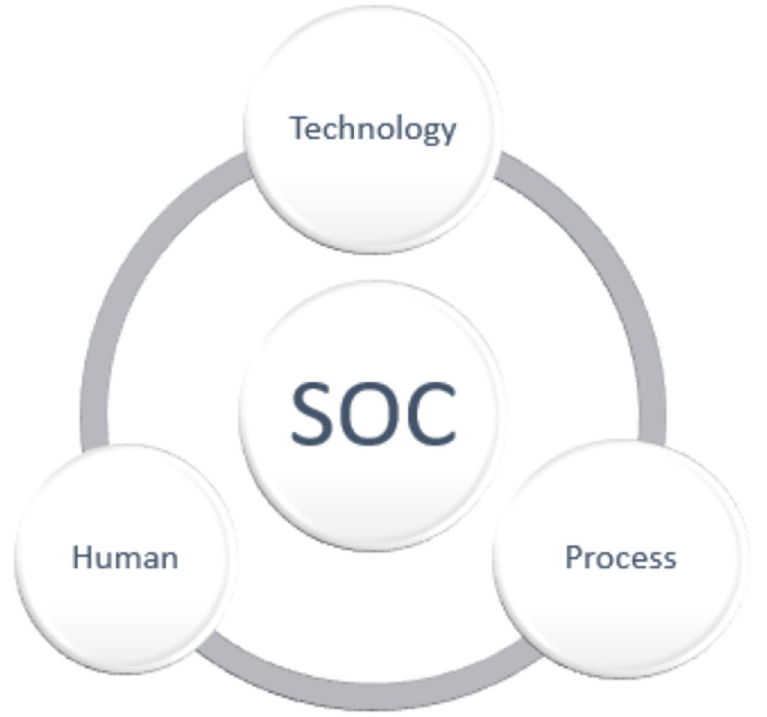
Fig 1. Conceptual model for the success of SOC